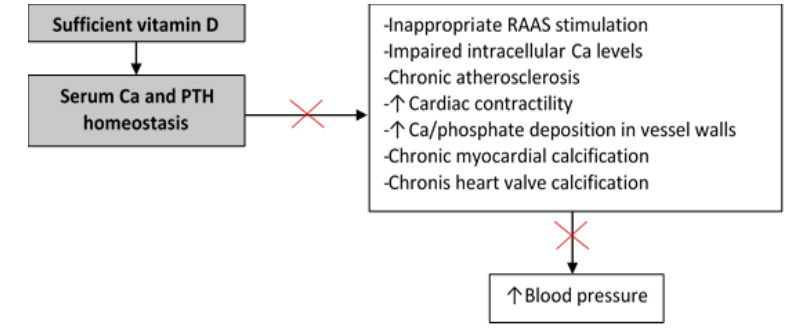
Figure 3. Vitamin D Maintains Blood Pressure through Ca and PTH homeostasis